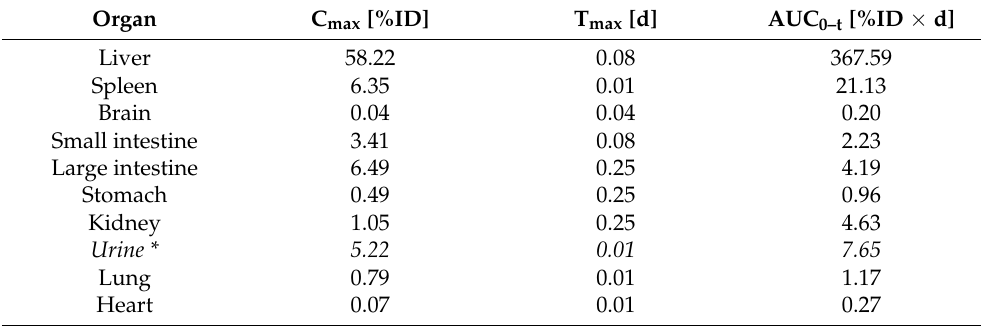
Table 2. Ex vivo pharmacokinetic parameters of 89 Zr-Exo following i.v. administration in various organs of ICR